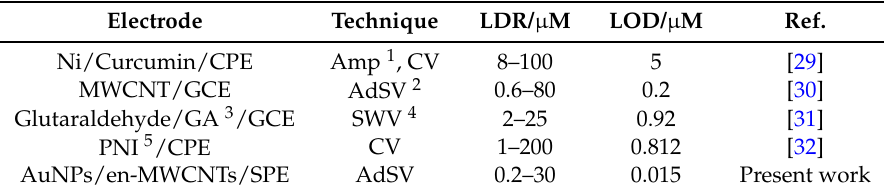
Table 1. Comparison of the proposed electrochemical sensor with previous reports on the voltammetric determination of